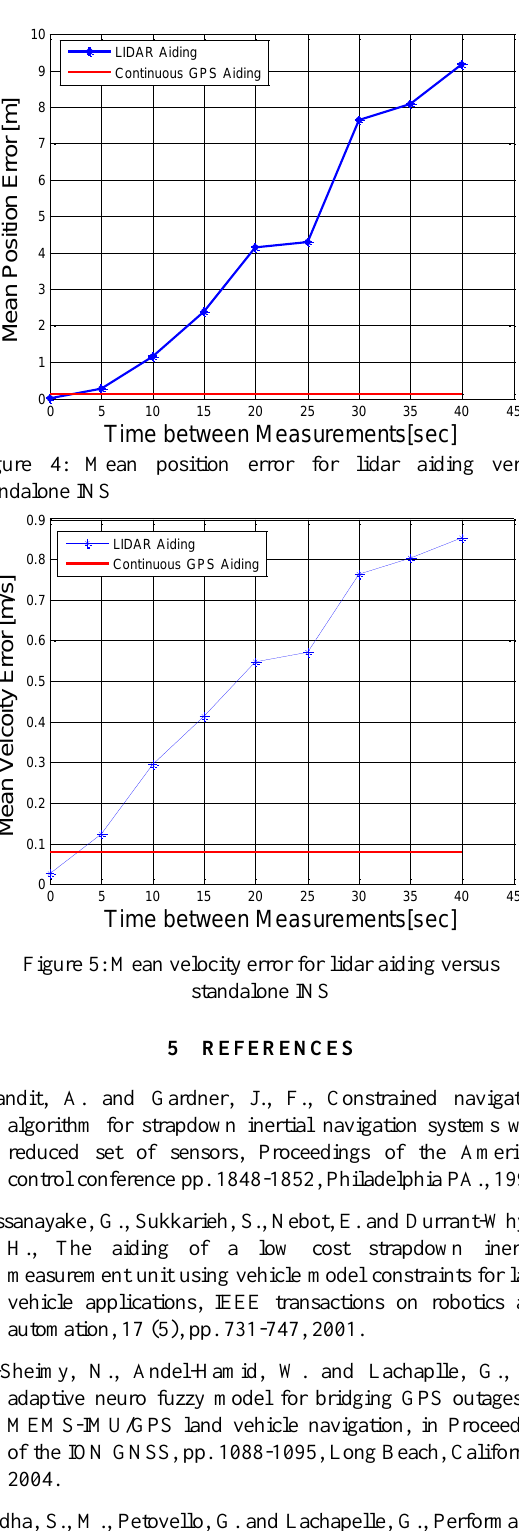
algorithm for strapdown inertial navigation systems